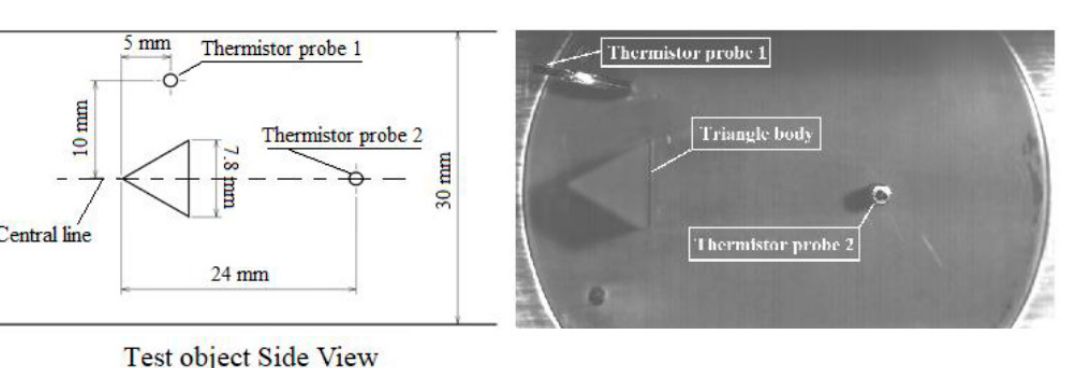
Figure 1. Overview of cavitation tunnel test section and thermistor probes. Credit: Le and Iga [31].